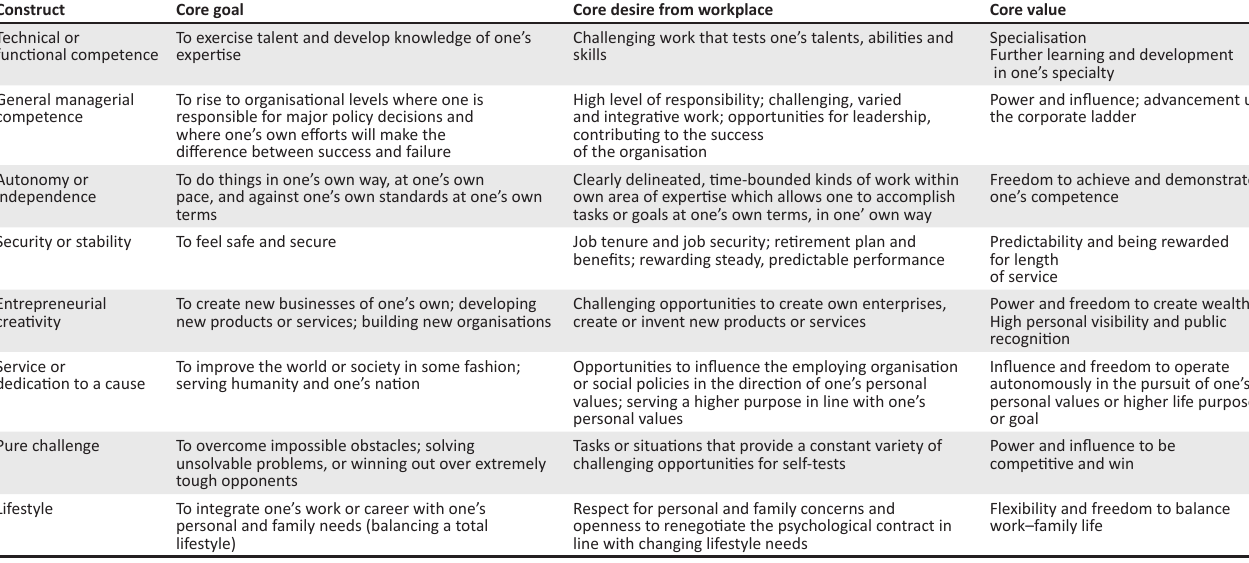
TABLE 2: Core underlying goals, desires and values underlying Schein’s (1990) career orientations (Coetzee, 2012).